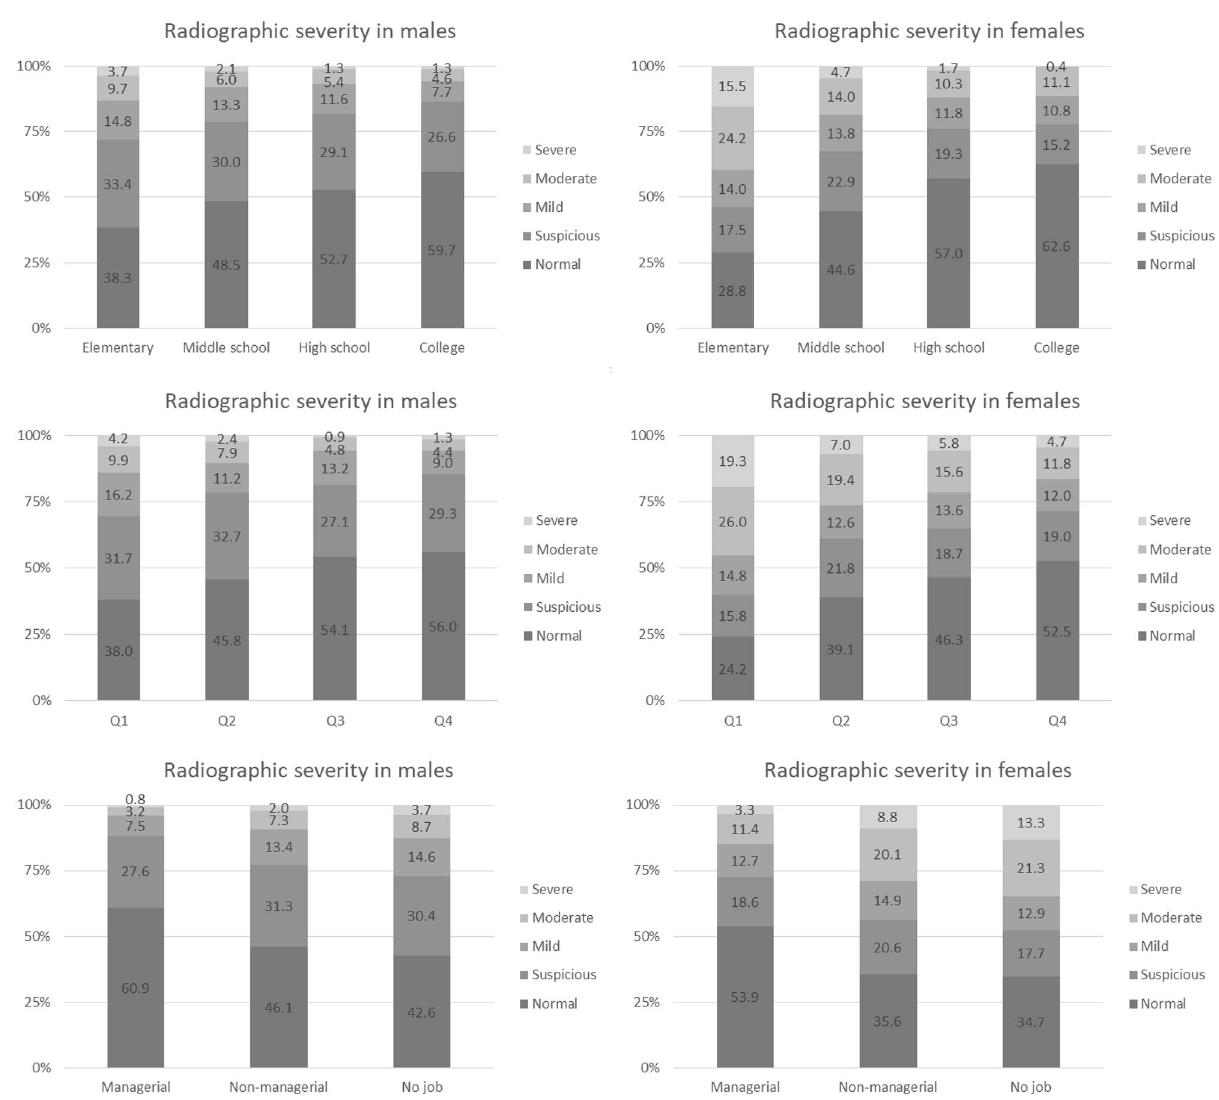
Figure 3. The radiographic severity of knee osteoarthritis (OA) according to income level, educational status, and